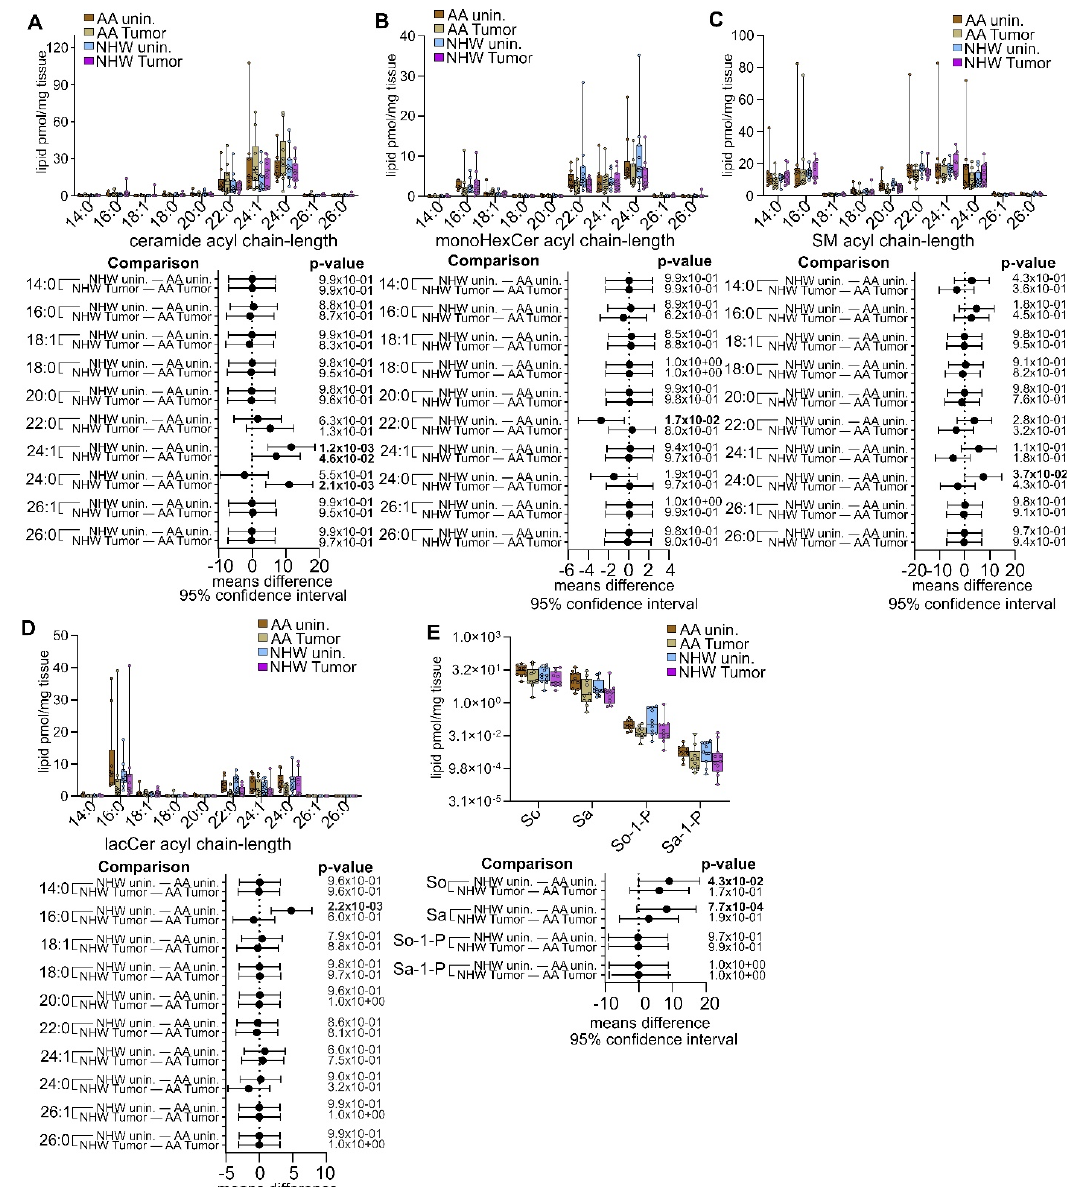
Figure 7. Secondary analysis comparisons of unin. vs. unin. and tumor vs. tumor sphingolipid profiles of self-identified AA and NHW males with HCC. Data presented in Figures 2M–P,X and 3M–P,X were analyzed to examine differences in the indicated lipids between unin. and tumor tissues of self-identified AA and NHW males with HCC. In each panel ( A – E ), the upper graphs are box plots showing medians (black line) and whiskers of min to max (top), and the bottom graphs are plots of the 95% family-wise significance and confidence intervals for predicted means difference